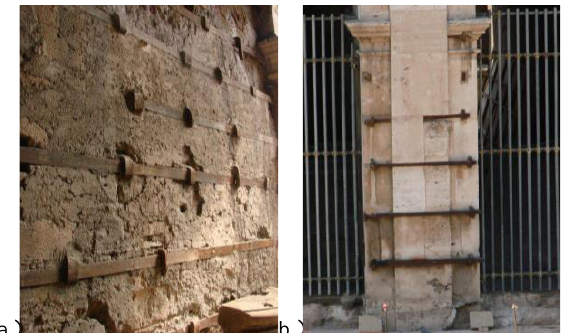
Figure 3. a.) Metal ties insert in the masonry wall behind